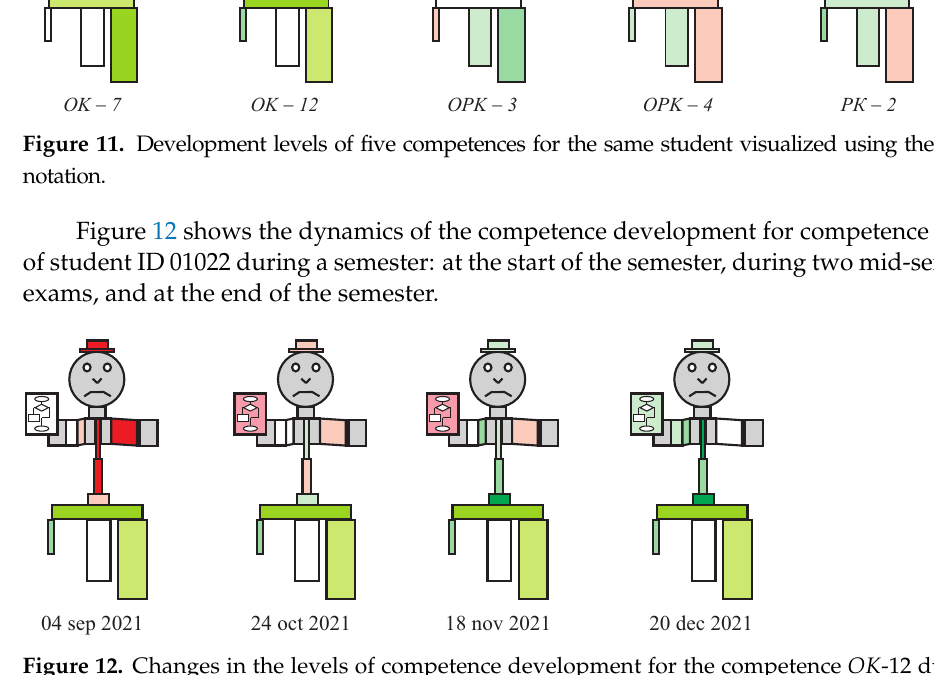
Figure 12. Changes in the levels of competence development for the competence OK -12 during a semester in the UGVA